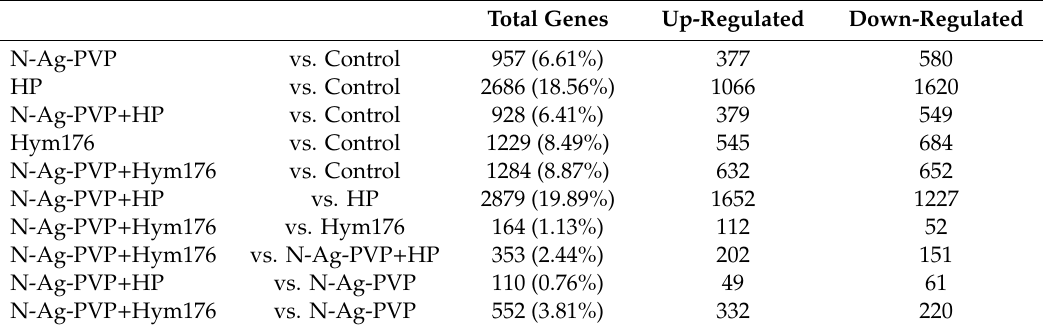
Table 3. Comparison of the number of genes with di ff erences in expression level. Total Genes Up-Regulated